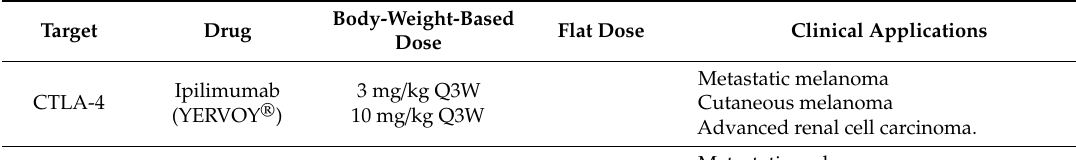
Table 1. Usual doses and clinical applications of Food and Drug Administration (FDA) approved immune check-point inhibitors (ICIs). CSCC, cutaneous squamous cell carcinoma; NSCLC: non-small cell lung cancer; TNBC, triple-negative breast